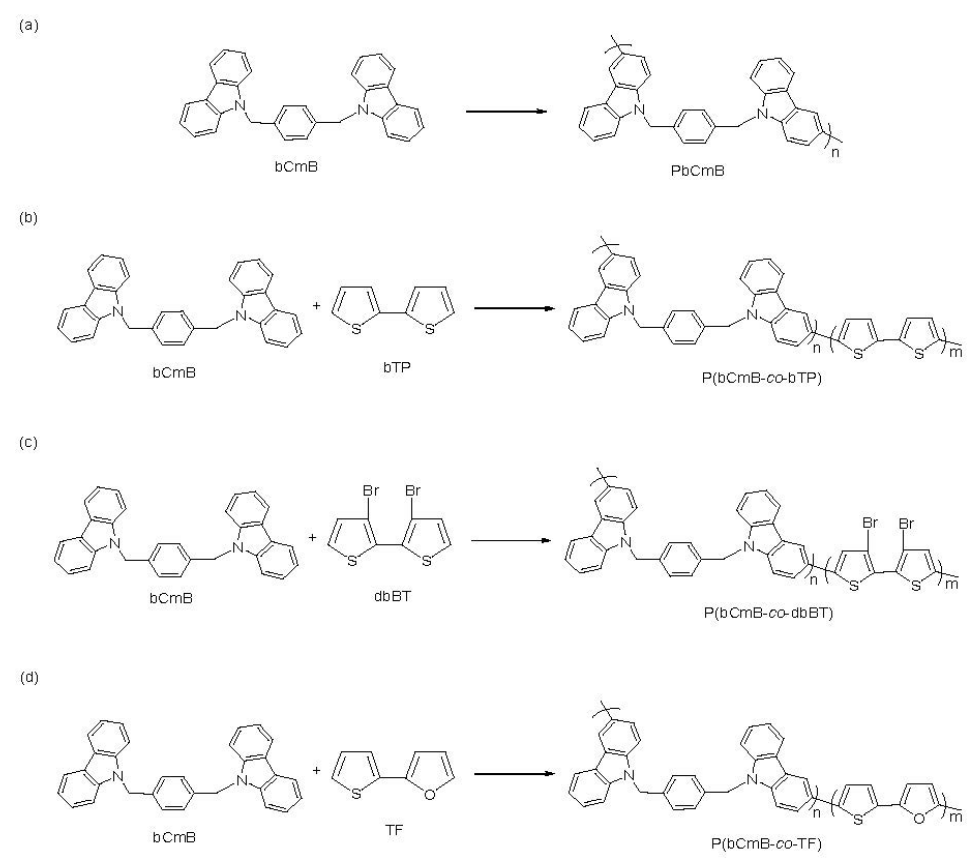
Figure 4. The electrochemical polymerization scheme of ( a ) PbCmB, ( b ) P(bCmB- co -bTP), ( c ) P(bCmB- co -dbBT), and ( d ) P(bCmB- co -TF).